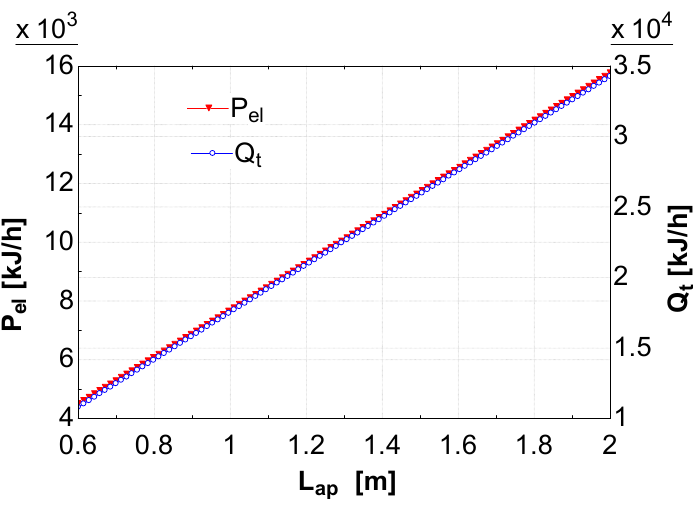
Figure 12. CPVT Electrical and Thermal Power vs. aperture